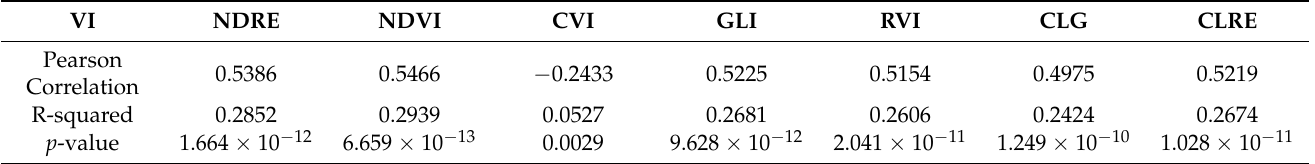
Table 1. Chlorophyll model performance. Seven vegetation indices were developed to model the chlorophyll content. All models are statistically significant. The seven indices are: normalized difference red edge (NDRE), normalized difference vegetation index (NDVI), chlorophyll vegetation index (CVI), green leaf index (GLI), ratio vegetation index (RVI), chlorophyll index green (CLG), and chlorophyll index red edge